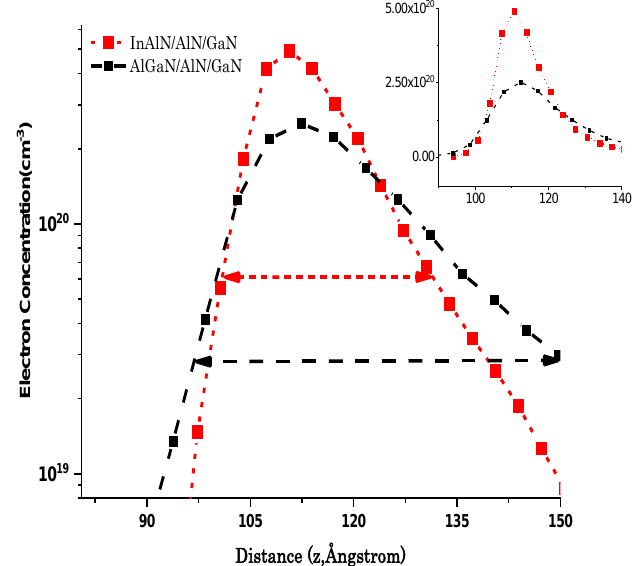
Figure 4. Comparison of the electron distribution of In 0.12 Al 0.88 N/AlN/GaN and case of Al 0.2 Ga 0.8 N/AlN/GaN for characteristics of 2DEG confinement.